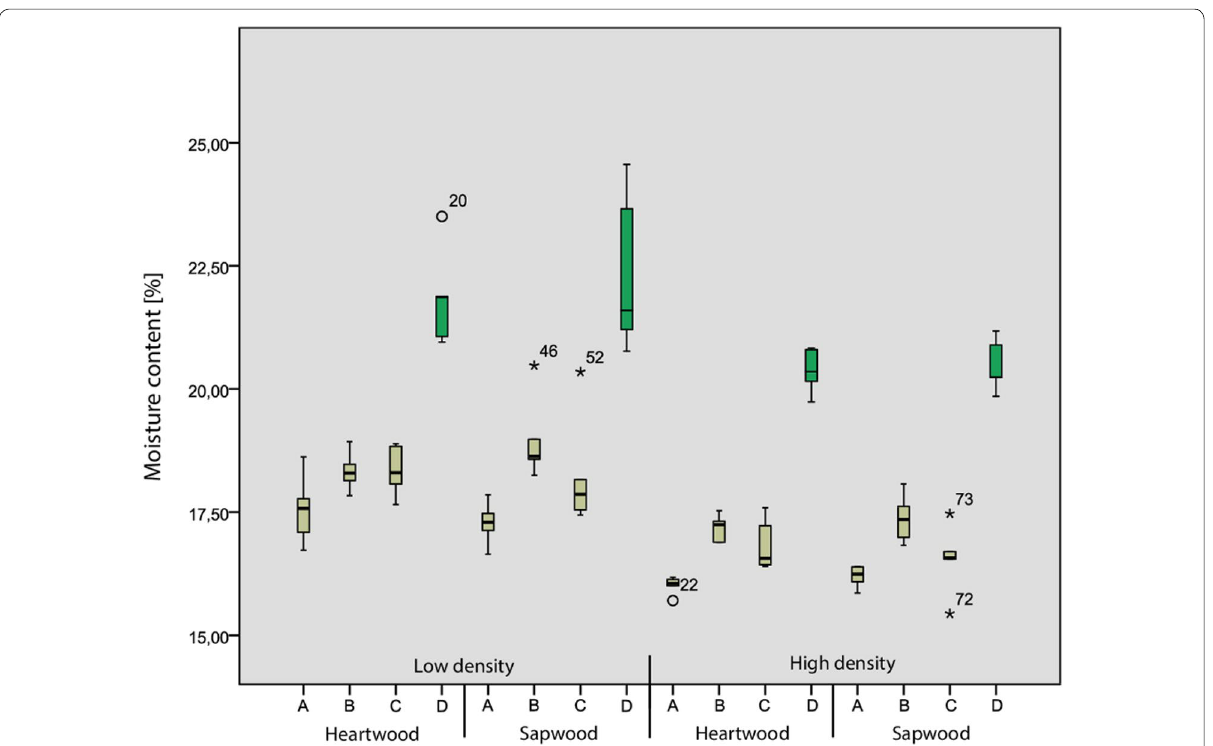
Fig. 2 Boxplot, the line in the box illustrates the median MC of five boards. The top and bottom of the box present the 25th and 75th percentiles, meaning 25% of the values are below the 25th percentile and 25% are above the 75th percentile. Approximately 95% of the values are expected to be within the upper and lower limits of the whiskers. The individual replicates highlighted with numbers in the graph (number 20, 22, 46, 52, 72 and